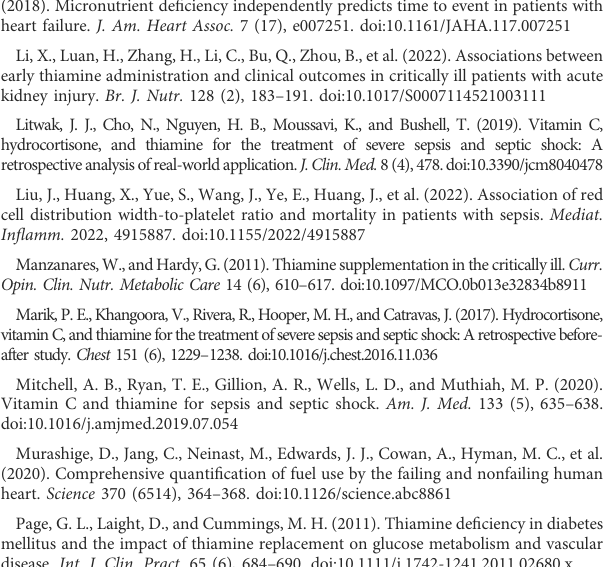
SUPPLEMENTARY FIGURE S1 Baseline difference between the thiamine and non-thiamine groups before and after propensity score